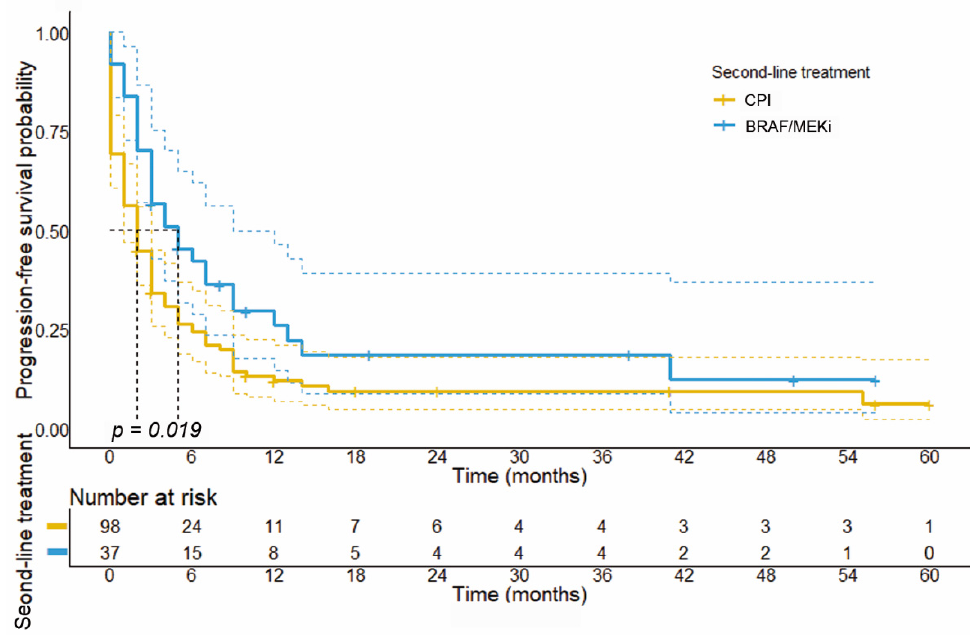
Figure 3. Progression-free survival stratified by the applied treatment in the second-line setting. Results from statistical survival analysis using log-rank test revealed that median PFS of patients with front-line CPI therapy was significantly longer compared to patients with front-line BRAF ± MEKi therapy (median PFS: 5.0 months, 95% CI: 1.6–8.4 vs. 2.0 months, 95% CI: 1.1–2.9; p =